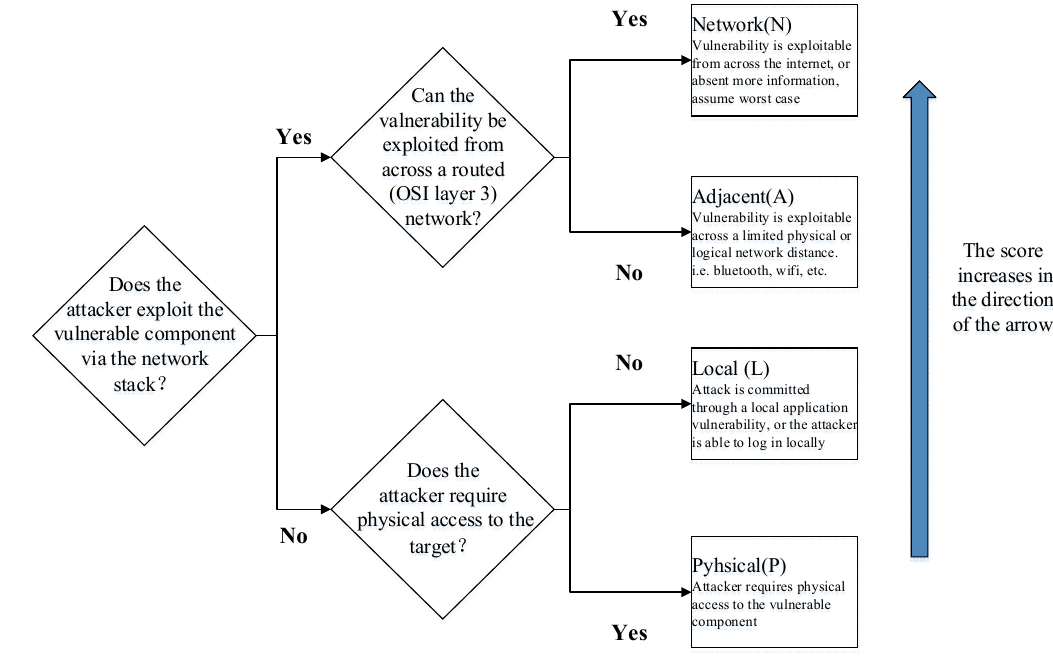
Figure 5. The scoring rubric for the Attack Vector metric.